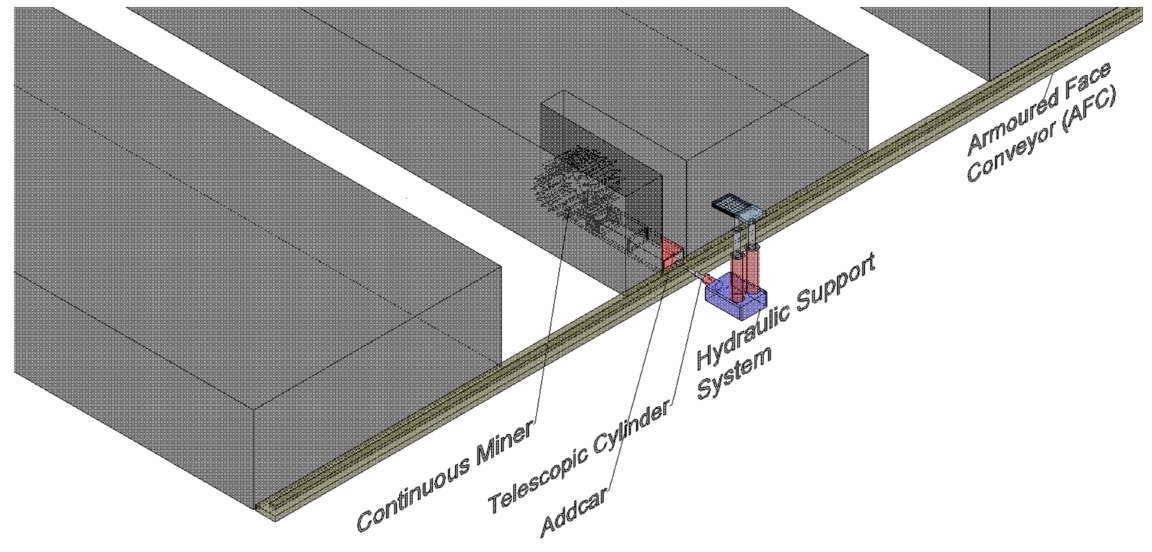
Figure 2. Mine equipment positioning (performed by the